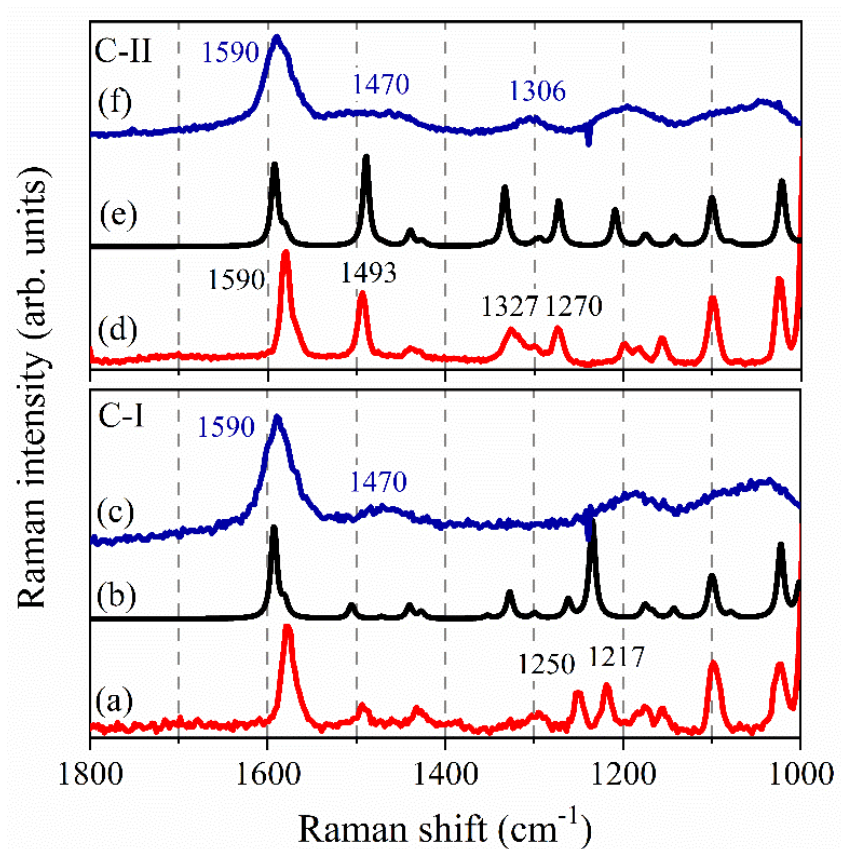
Figure 3. Raman spectra acquired on the pristine drugs C-I ( a ) and C-II ( d ) and theoretical Raman activity computed for the molecules of C-I ( b ) and C-II ( e ) in the spectral region 1100–1800 cm −1 ; UV resonant Raman (UVRR) spectra acquired on C-I ( c ) and C-II ( f ) dissolved in methanol.